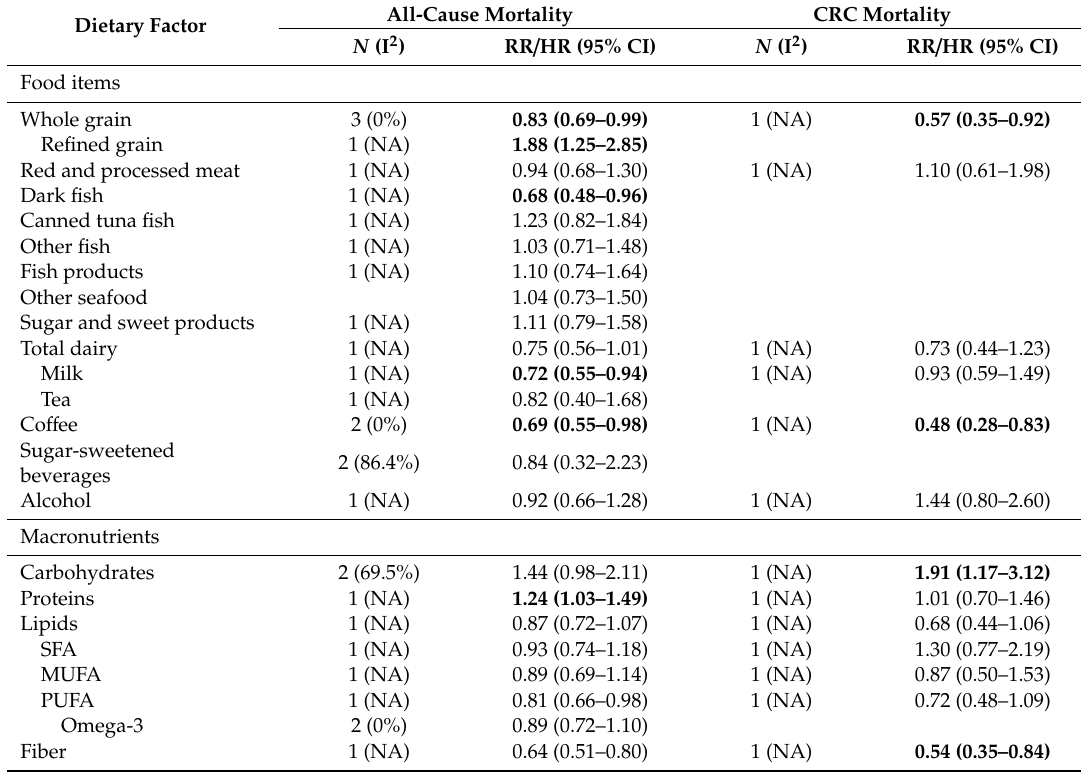
Table 3. Systematic review and meta-analysis of the associations between postdiagnostic dietary